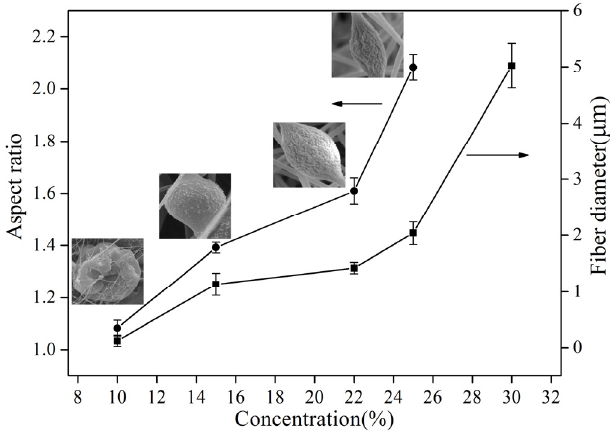
Figure 6. Aspect ratio of beads and fiber diameter of PS fibers with different